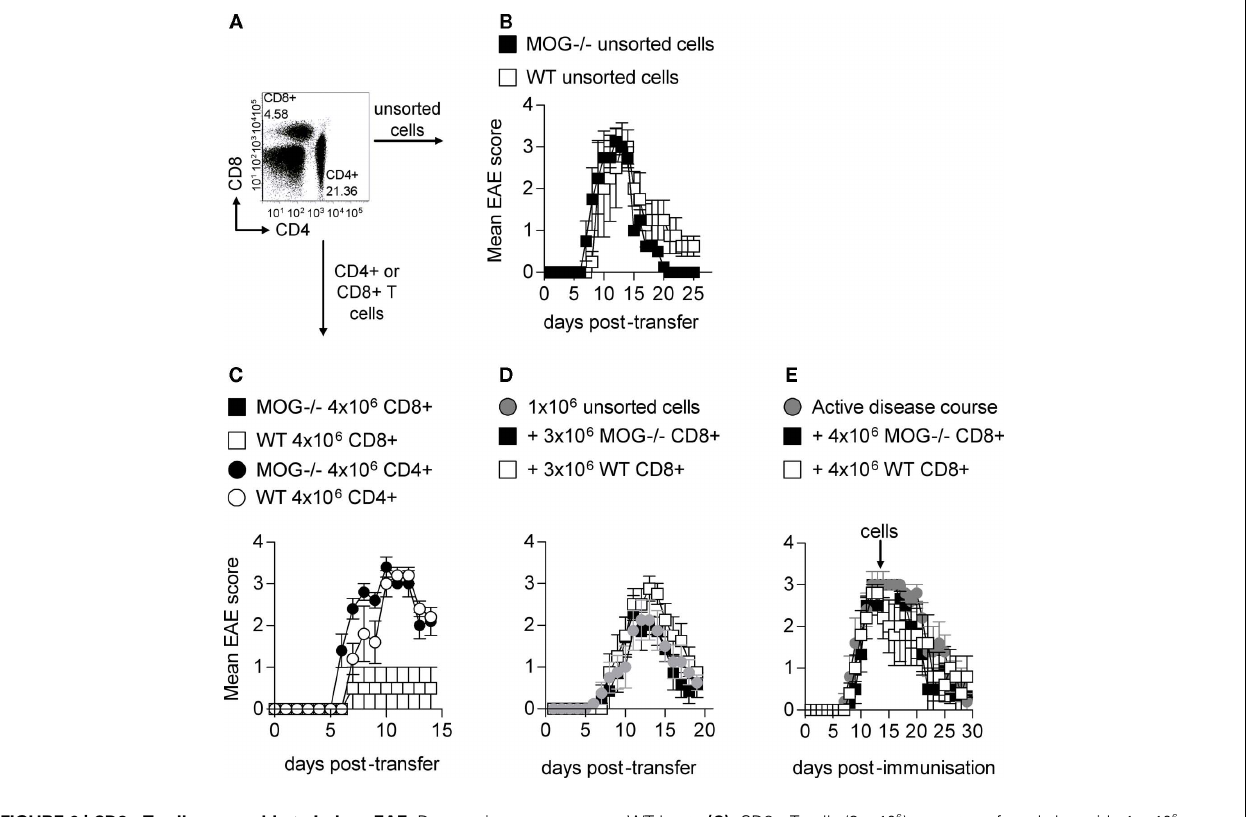
FIGURE 6 | CD8 + T cells are unable to induce EAE. Donor mice were immunized with 100 μ g pMOG in CFA.Ten days later, LN cells were restimulated with pMOG for 3days in the presence of IL-12 and IL-18. Cells were analyzed pre-transfer for CD4 + and CD8 + T cells within the donor population (A) . Unsorted cells were injected i.v. intoWT host mice (B) . CD4 + and CD8 + T cells were purified by FACS and injected into